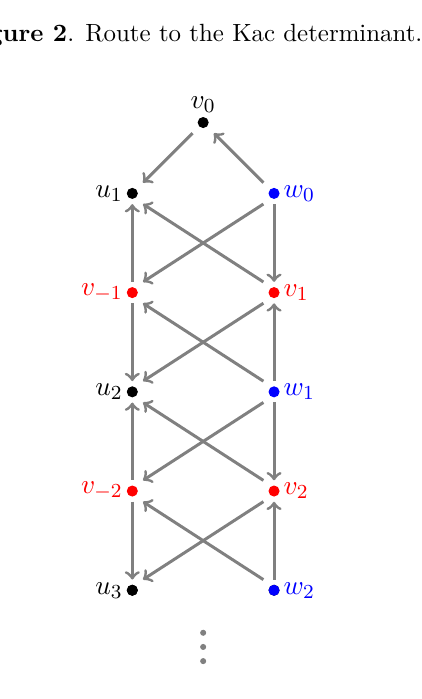
Figure 3 . Feigin-Fuchs characterization of the Fock space